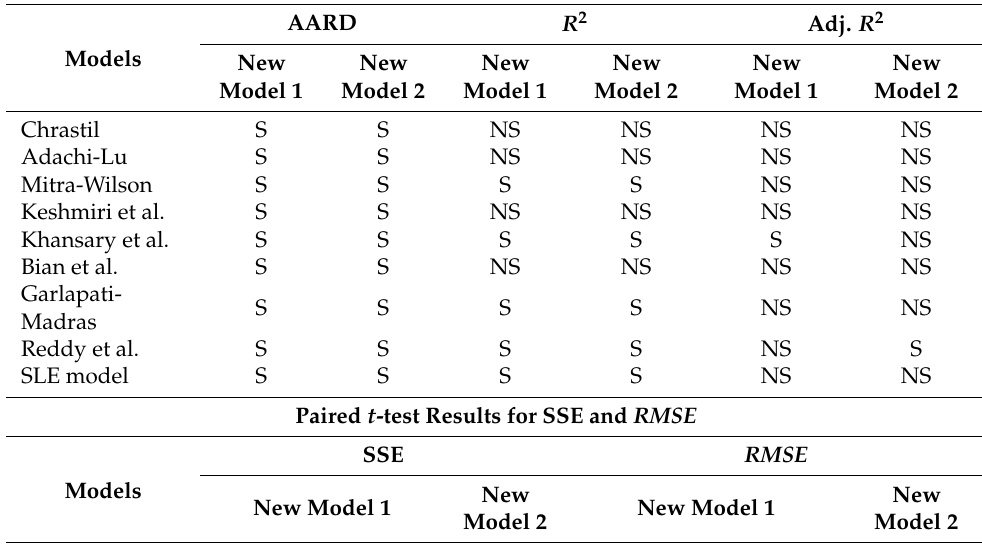
Table 7. a. Paired t -test results for averaged absolute relative deviation (AARD), R 2 and Adj. R 2 , b. Paired t -test results for sum of squares due to error (SSE) and RMSE. Paired t -test Results for AARD, R 2 and Adj. R